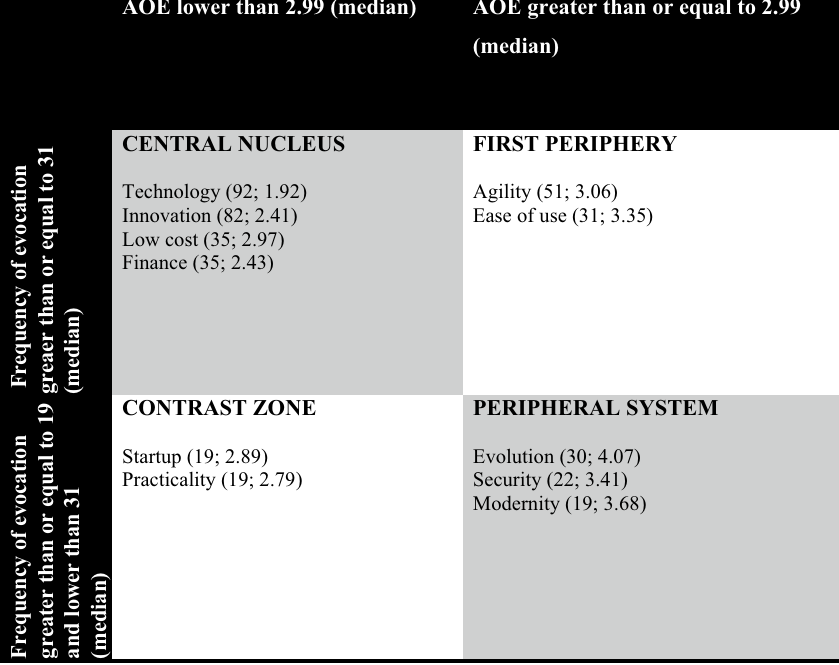
Fig. 2 Vergès’ four-quadrant framework for